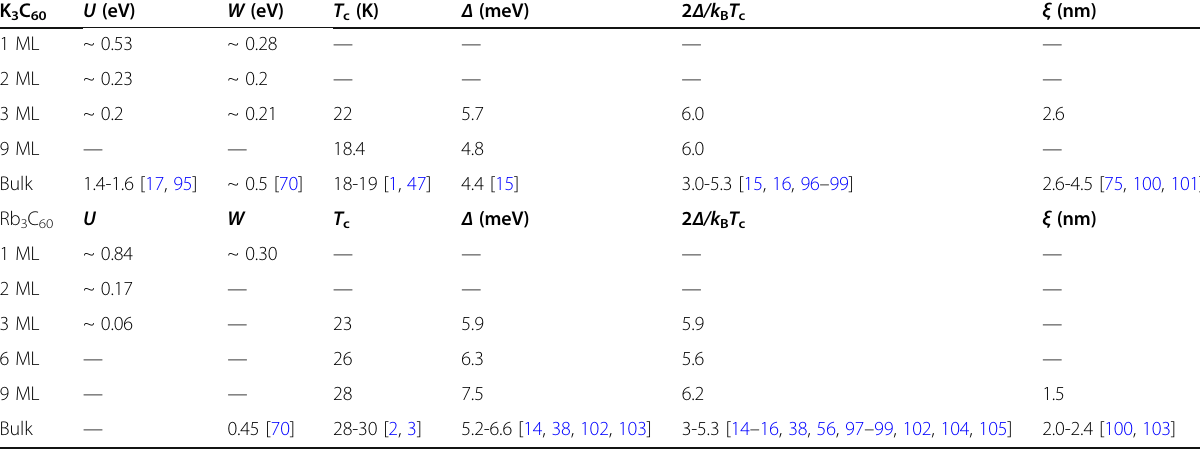
Table 2 A brief summary of some parameters of A x C 60 films and bulks. Data of thin films are taken from ref. [44 – 46] K 3 C